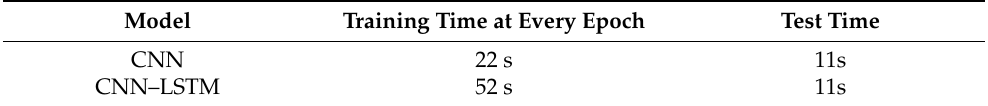
Table 4. Time comparison of the two